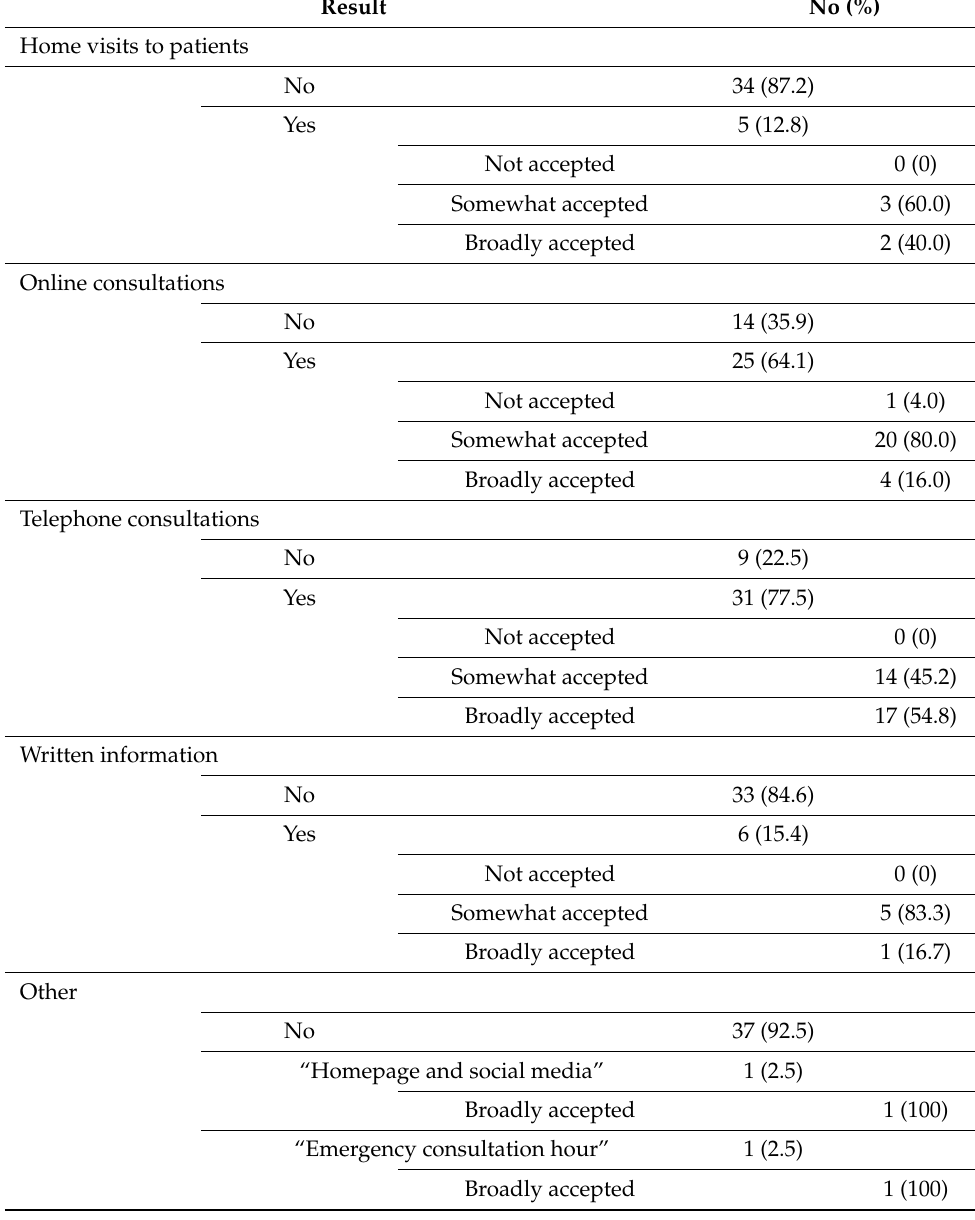
Table 1. Alternative medical care options for PD patients during the pandemic. Participating physi- cians offered several alternative medical care options, which were received differently by